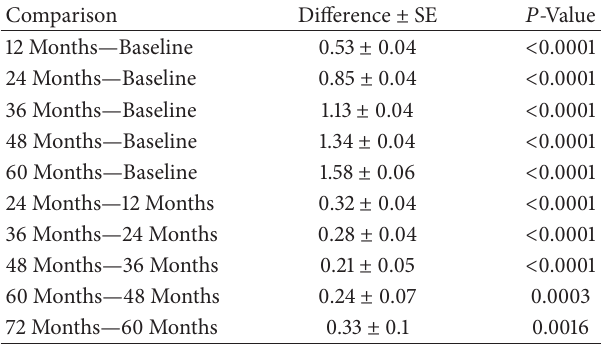
Table 4: Comparison of 𝑇 -scores over periods of testosterone